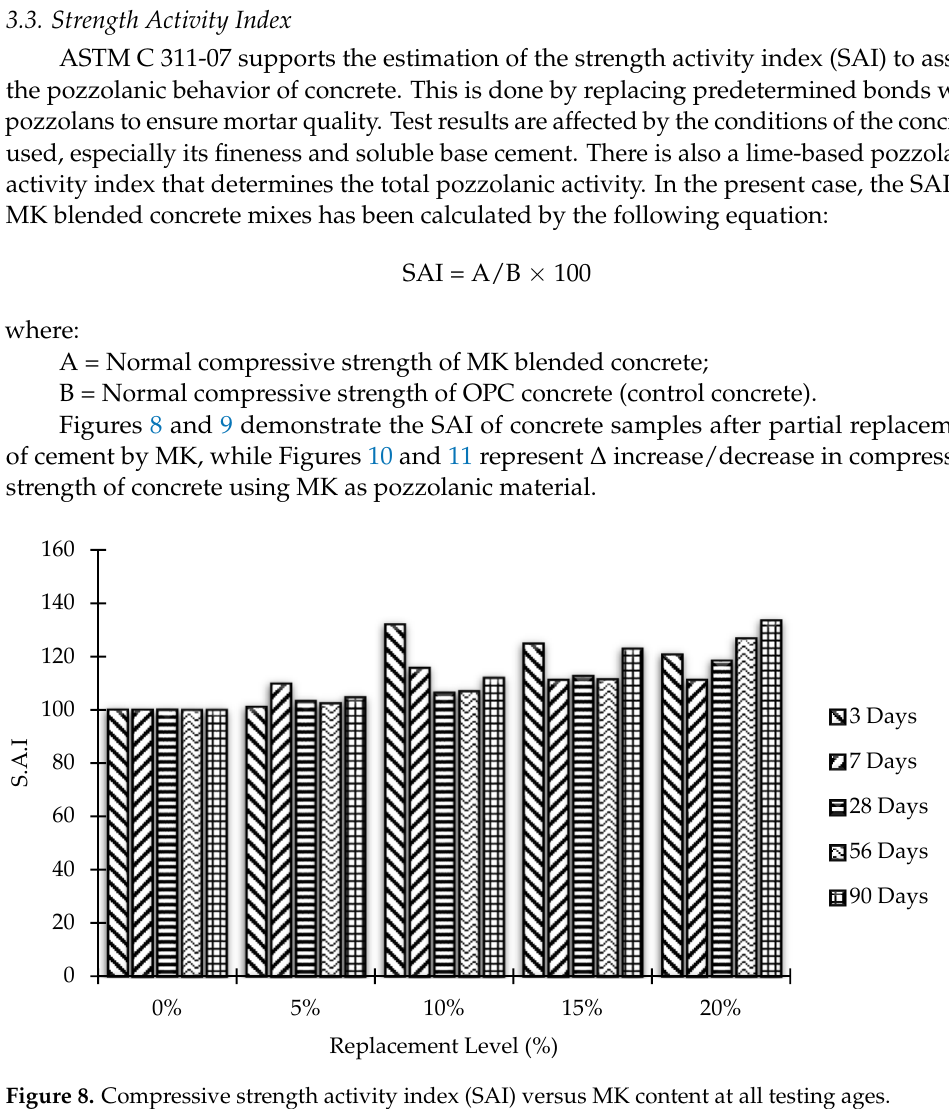
Figure 8. Compressive strength activity index (SAI) versus MK content at all testing ages.